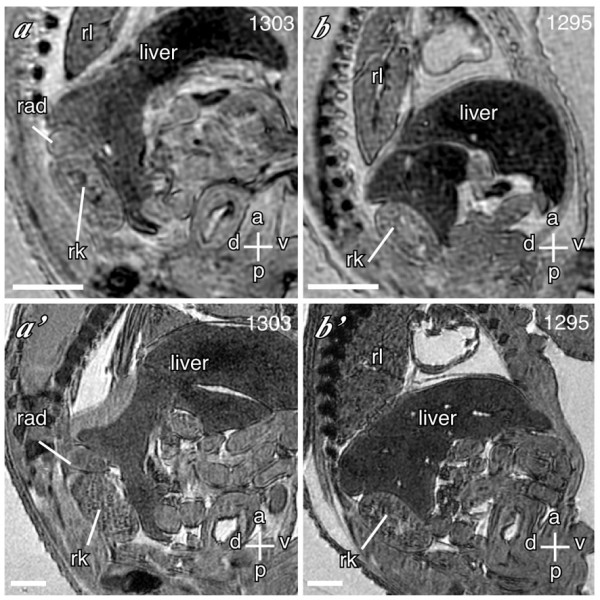
Identification of adrenal agenesis using multi-embryo MRI Images of coronal sections from 2 embryos obtained using the multi-embryo technique (a, b) compared with images from the same embryos obtained subsequently using the single embryo technique (a', b'). (a, a') Normal right adrenal gland (rad) anterior to the right kidney (rk) in a wild-type embryo. The right lung (rl) is indicated. (b, b') Agenesis of right adrenal gland in a Cited2-/- embryo. Scale bars = 635 μm for multi-embryo, and 317 μm for single embryo images; axes: d – dorsal; v – ventral; a – anterior, p – posterior.